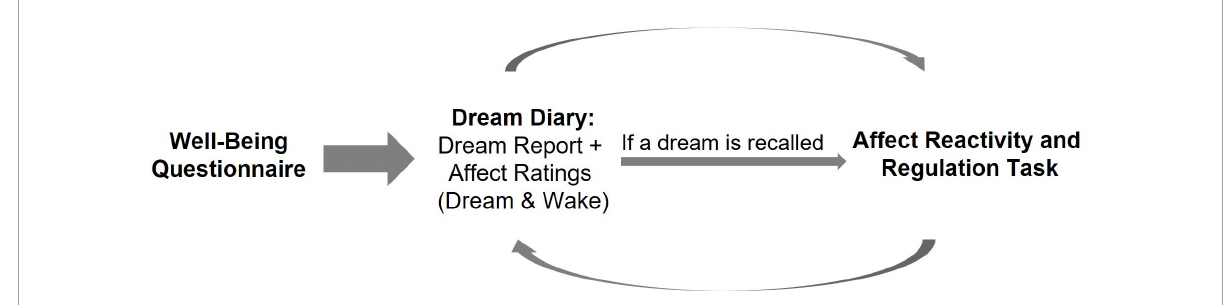
FIGURE1 Procedure of the study. Participants first completed the well-being questionnaire. Thereafter, every morning upon awakening, they logged on to an online dream diary in which they answered questions about bed-time, waking time, sleep quality, and whether they remembered any dreams that night. If they recalled a dream, participants were asked to provide a narrative dream report and to rate the affect they experienced in the dream using dimensional and discrete affect rating scales. Participants also rated their post-sleep waking affect level. On the mornings when participants recalled a dream and provided dream affect ratings, they were instructed to carry out an affect reactivity and regulation task immediately upon filling in the dream diary. This procedure (i.e., filling in the dream diary and performing the task) was continued each morning until the participants had provided dream affect ratings and carried out the task five times (i.e., on five